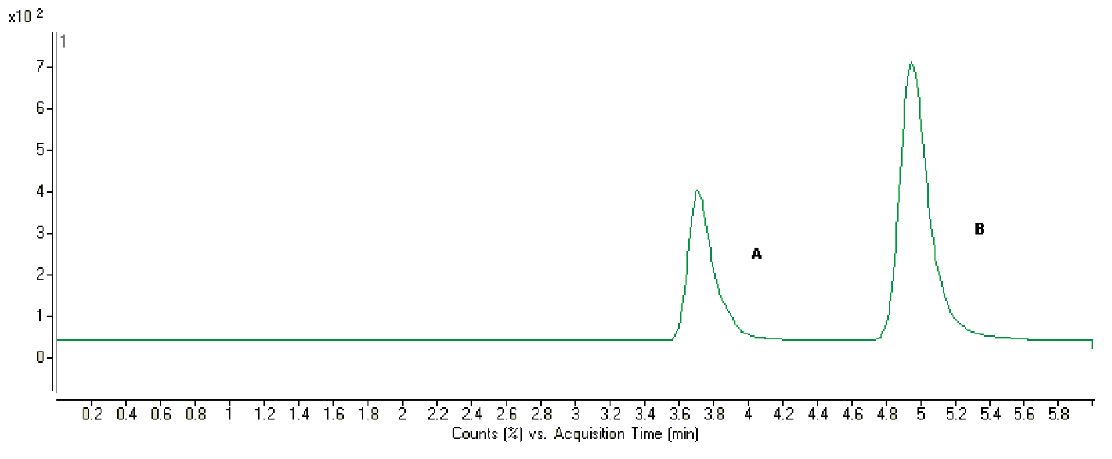
Figure 2. Chromatograms of plasma spiked with triptolide and IS. A: IS; B: